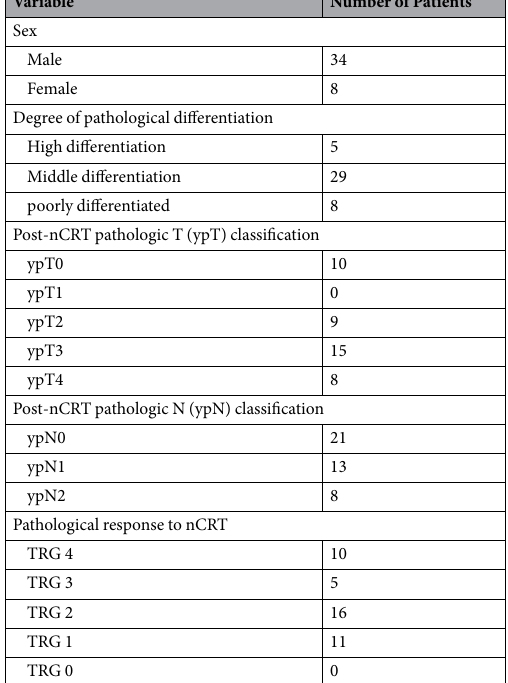
Table 1. Clinical and pathological characteristics of the enrolled 42 patients. nCRT, neoadjuvant chemoradiotherapy; TRG, tumor regression